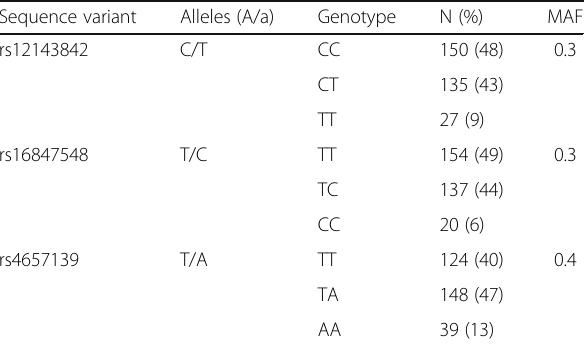
Table 2 Allele frequencies for three non-coding